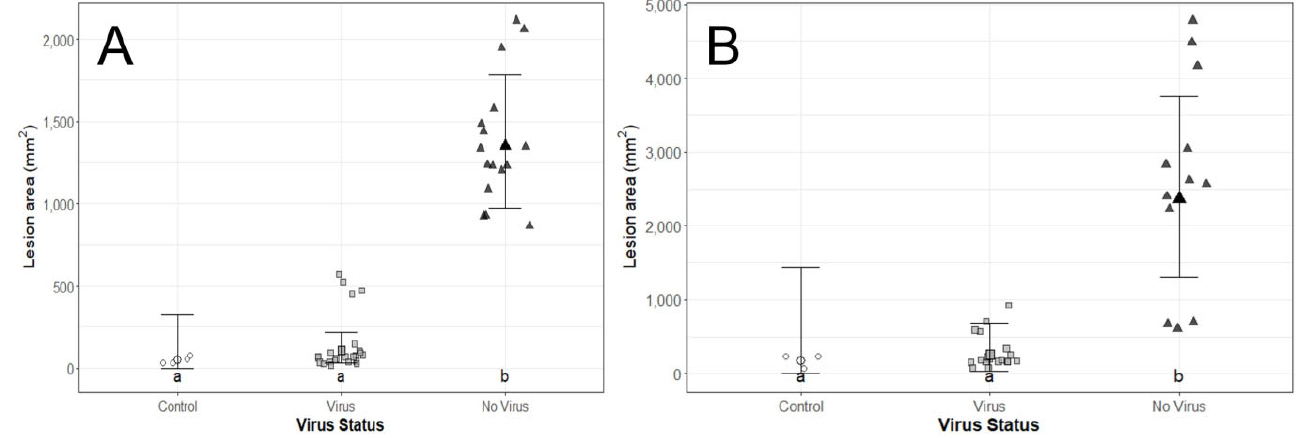
Figure 2. Lesion area produced by virus ‐ infected and virus ‐ free C. parasitica isolates. Points with error bars represent estimated marginal means with 95% confidence intervals. Lettering indicates significant differences by treatment. ( A ) Seedlings. ( B ) Branch segments. See Material and Methods third paragraph for experimental details.